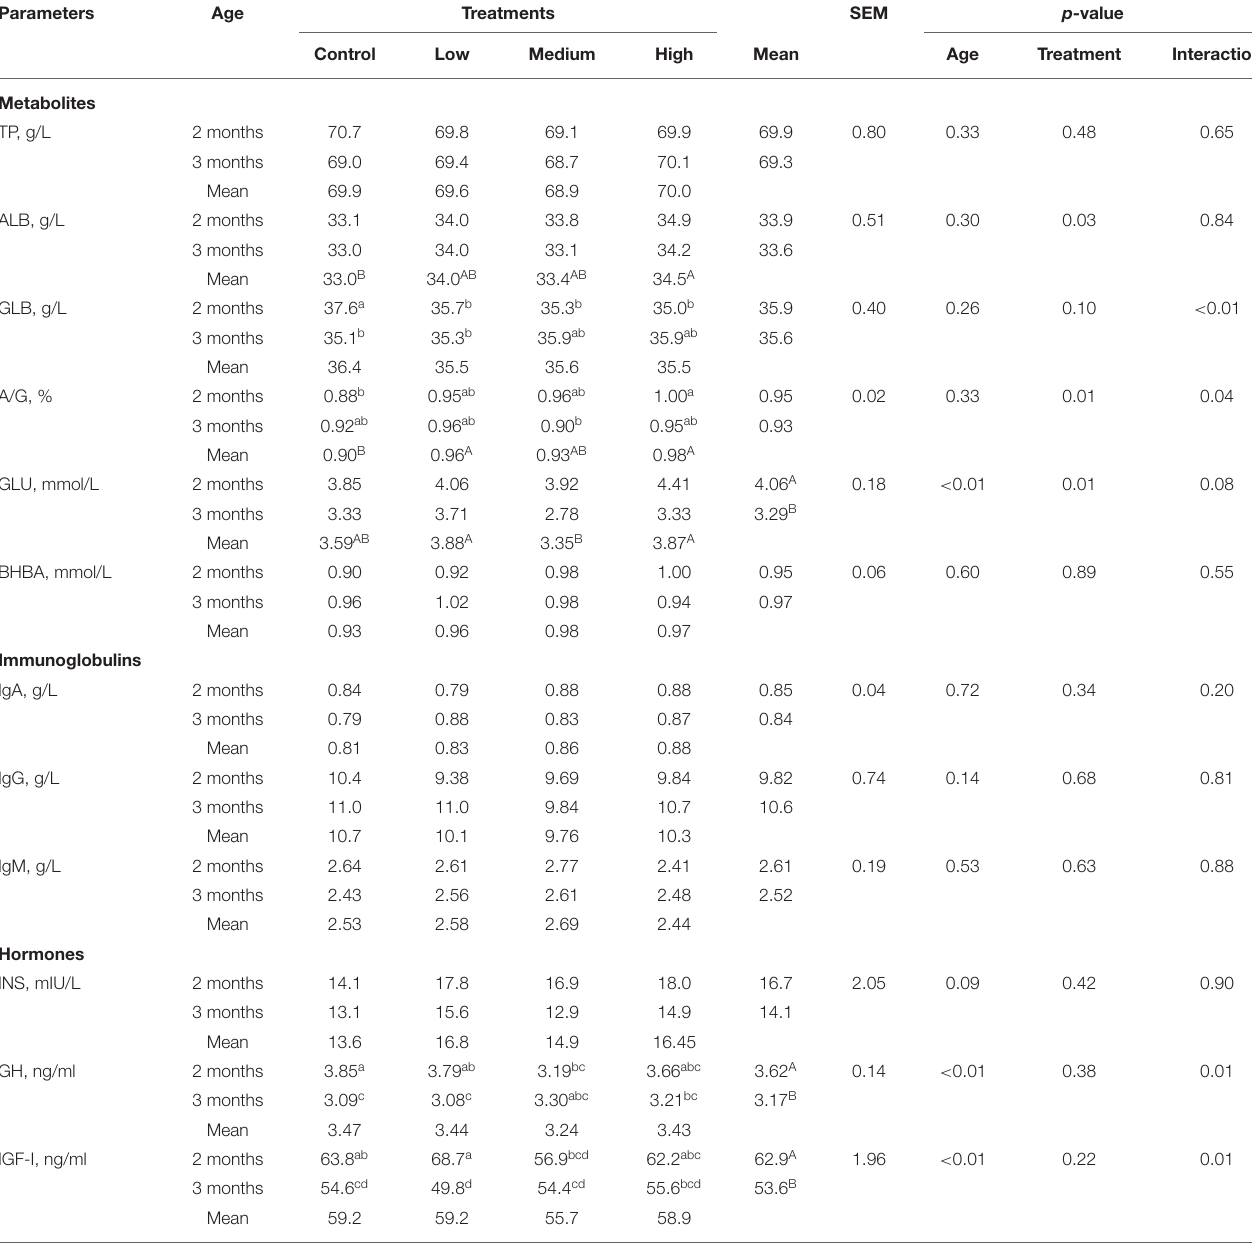
TABLE 3 | Effect of dietary BHBA on blood parameters of goat kids ( n = 6 per group). Parameters Age Treatments SEM p -value Control Low Medium High Mean Age Treatment Interaction